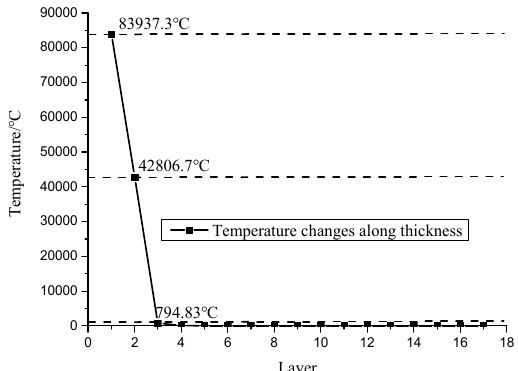
Figure 7. Temperature change along the thickness direction.